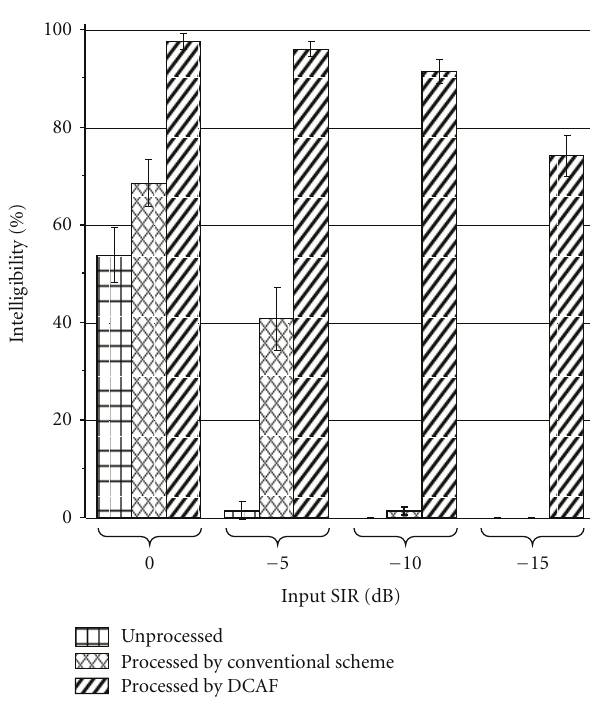
Figure 10: Intelligibility with three processing